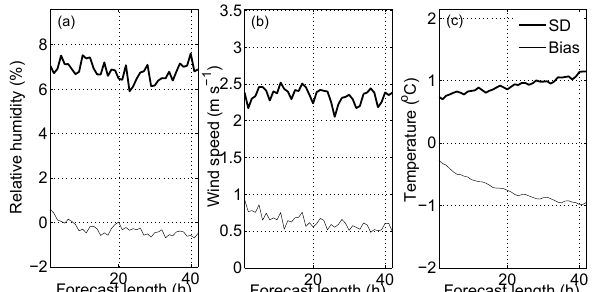
Figure 4. CM: unbiased forecast error SD and bias for (a) relative humidity in percent, (b) wind speed in ms − 1 and (c) temperature in ◦ C for increasing forecast length. The statistical measures are cal- culated for the 2-week period and averaged over all available sta- tions. The meteorological observations at 60 to 150m height above ground from 10 sites (9 for wind speed) are